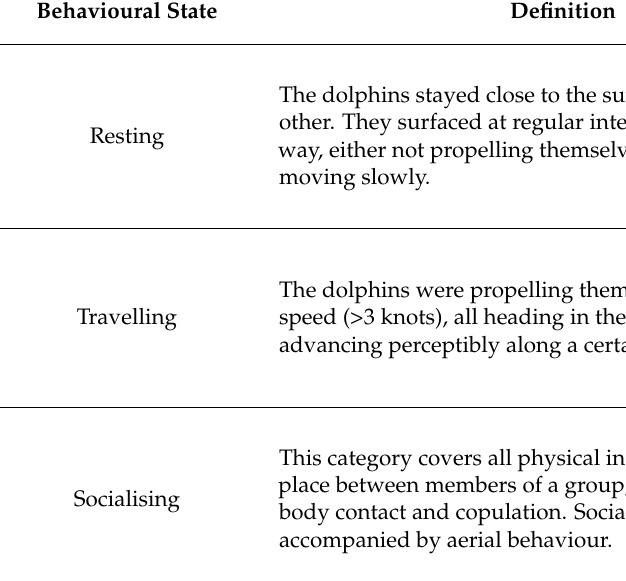
Table 1. Ethogram of the spinner dolphins’ behavioural states recorded during the focal group follows. Adapted from Shane [49], Stensland and Berggren [51], Stockin et al. [52], Norris and Dohl [53], Norris et al. [54] and Christiansen et al. [11]. Spinner Dolphin Groups during the Definition Study (Credits: CEDTM, A. Nguyen)